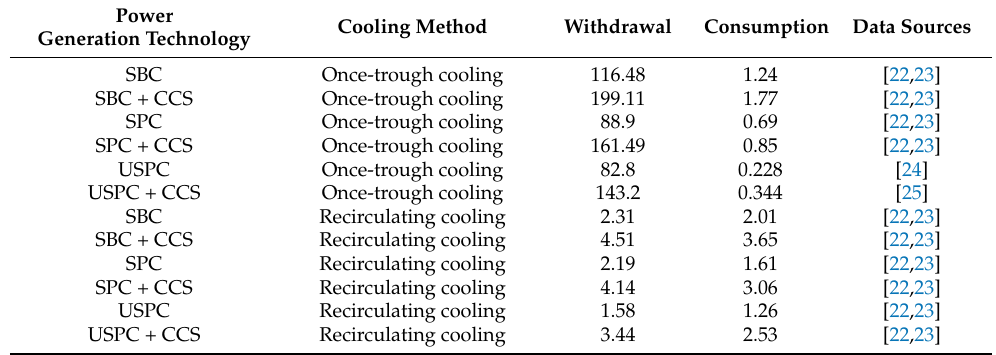
Table 1. Water withdrawal and consumption of per unit power generation in different power plants with/without CCS (m 3